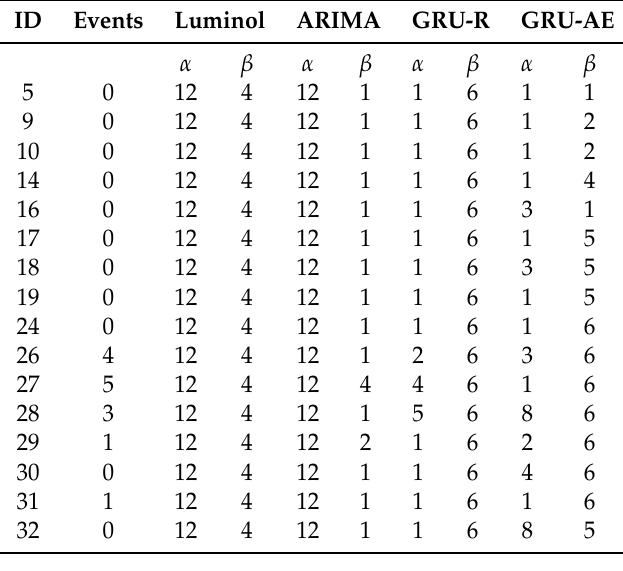
Table 3. Table of results for the grid search-optimised implementation of LinkedIn’s anomaly detection library (Luminol), the grid search-optimised ARIMA model, PSO-optimised threshold-based anomaly detection of loss incurred from a GRU-based regression, and PSO-optimised threshold-based anomaly detection of the Mahalanobis distance produced by a GRU-based autoencoder. α and β denote the start and length of the time window (in days), respectively, for which an alert is assessed, and τ is the threshold the loss/Mahalanobis distance needed to exceed in order to raise an alert. They are optimised using training data O e ; these results are from the test data O t